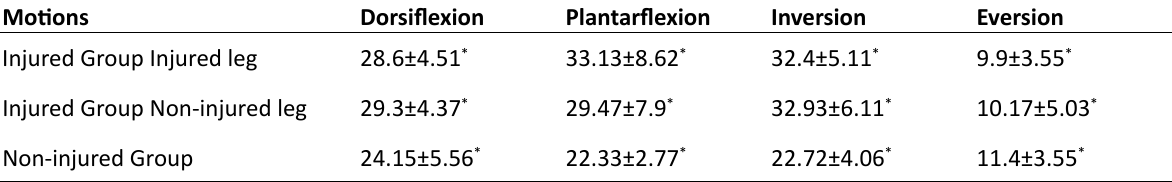
Table 2. Comparison of ROM degree (Mean±SD) within Injured group (Injured leg & non-injured leg) with Non-injured group